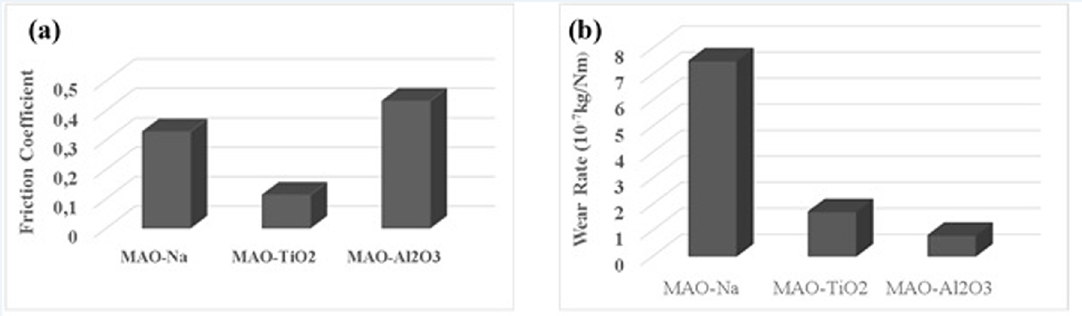
Figure 3. MAO-Na, MAO-TiO